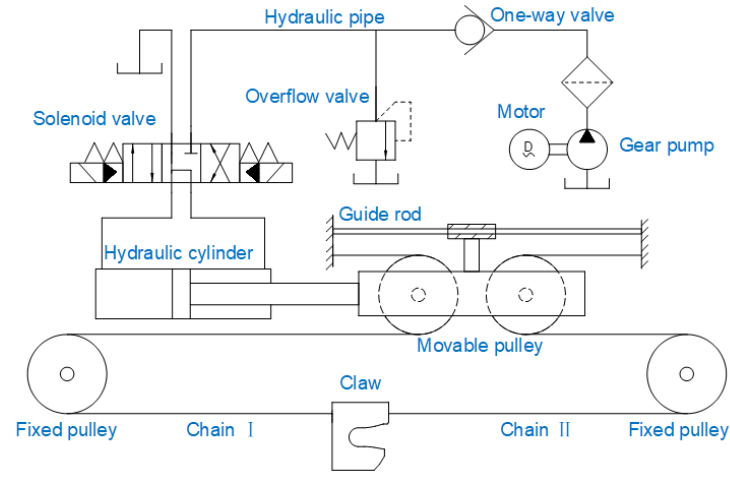
Figure 3. The transmission system schematic diagram of HTD.